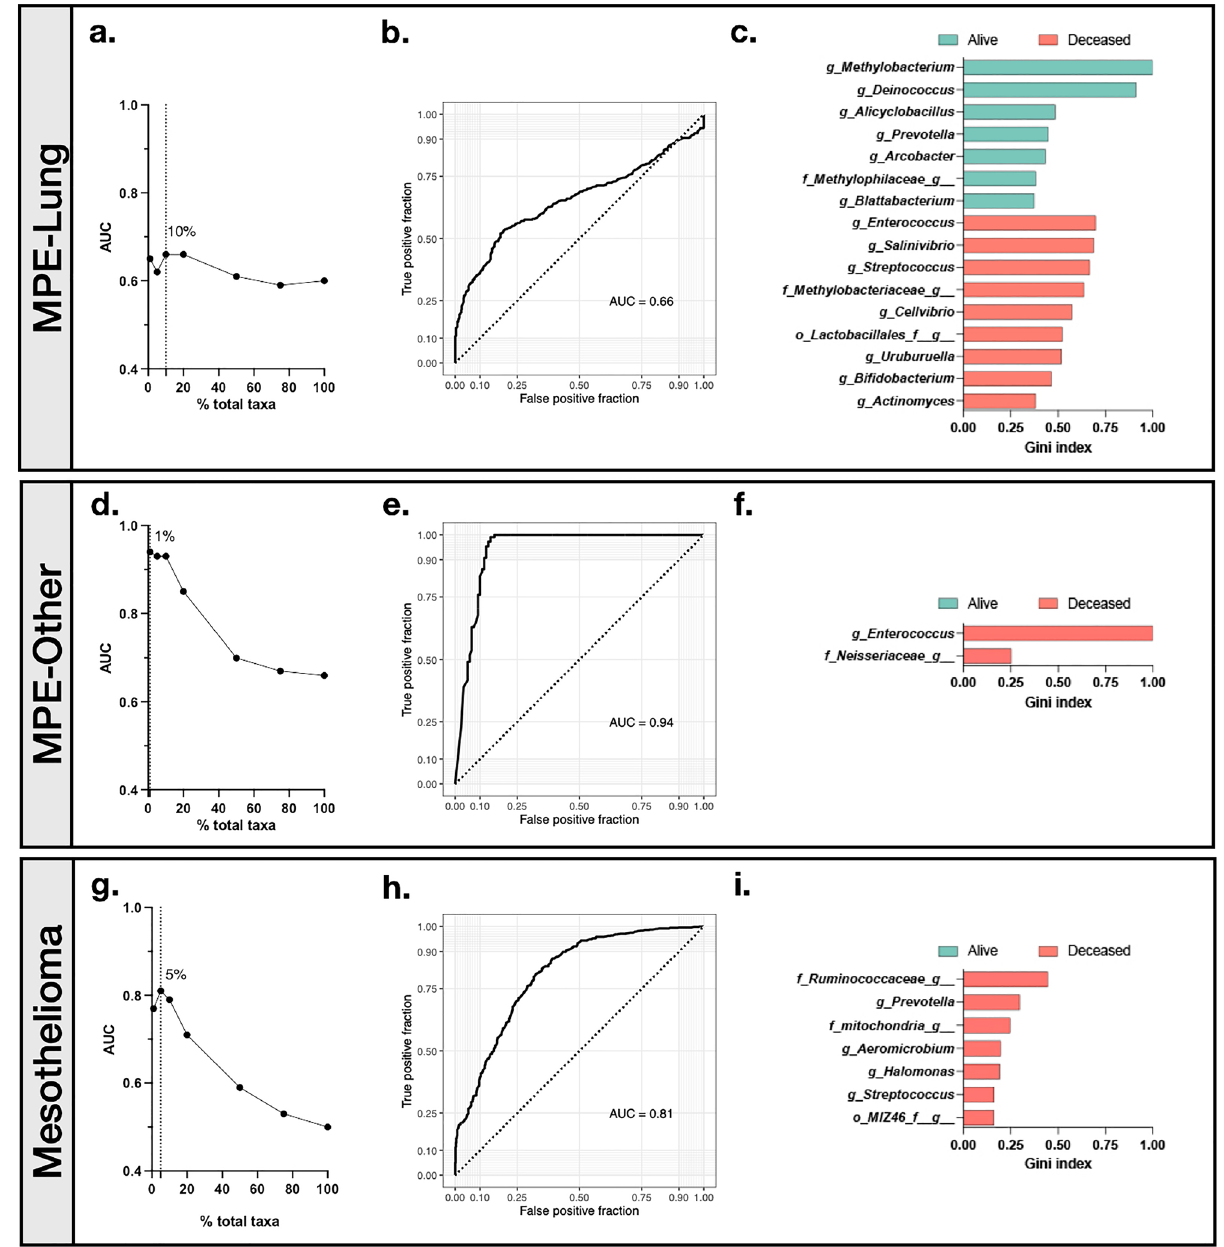
Figure 4. Random forest classifiers to predict mortality at median time of survival. ( a ) Area under the curve (AUC) of receiver operator curves (ROC) based on random forest identification of taxonomic classifiers predicting mortality in MPE-Lung median mortality (33.6 months) using the top 1, 5, 10, 20, 50, 75, and 100% of total discriminant taxa based on Gini values ( n = 343). ( b ) ROC for the best-fit random forest classifier in MPE-Lung. ( c ) Taxa with greatest Gini Index from the random forest classifier with the greatest AUC (10% of taxa). ( d ) AUC of ROC based on random forest identification of taxonomic classifiers predicting mortality in MPE-Other median mortality (36 months) using the top 1, 5, 10, 20, 50, 75, and 100% of total discriminant taxa based on Gini values ( n = 254). ( e ) ROC for the best-fit random forest classifier in MPE-Other. ( f ) Taxa with greatest Gini Index from the random forest classifier with the greatest AUC (1% of taxa). The taxa colored in purple is a potential contaminant. ( g ) AUC of ROC based on random forest identification of taxonomic classifiers predicting median mortality in Mesothelioma (19.6 months) using the top 1, 5, 10, 20, 50, 75, and 100% of total discriminant taxa based on Gini values ( n = 503). ( h ) ROC for the best-fit random forest classifier in Mesothelioma. ( i ) Taxa with greatest Gini Index from the random forest classifier with the greatest AUC (5% of taxa). Potential contaminants are not